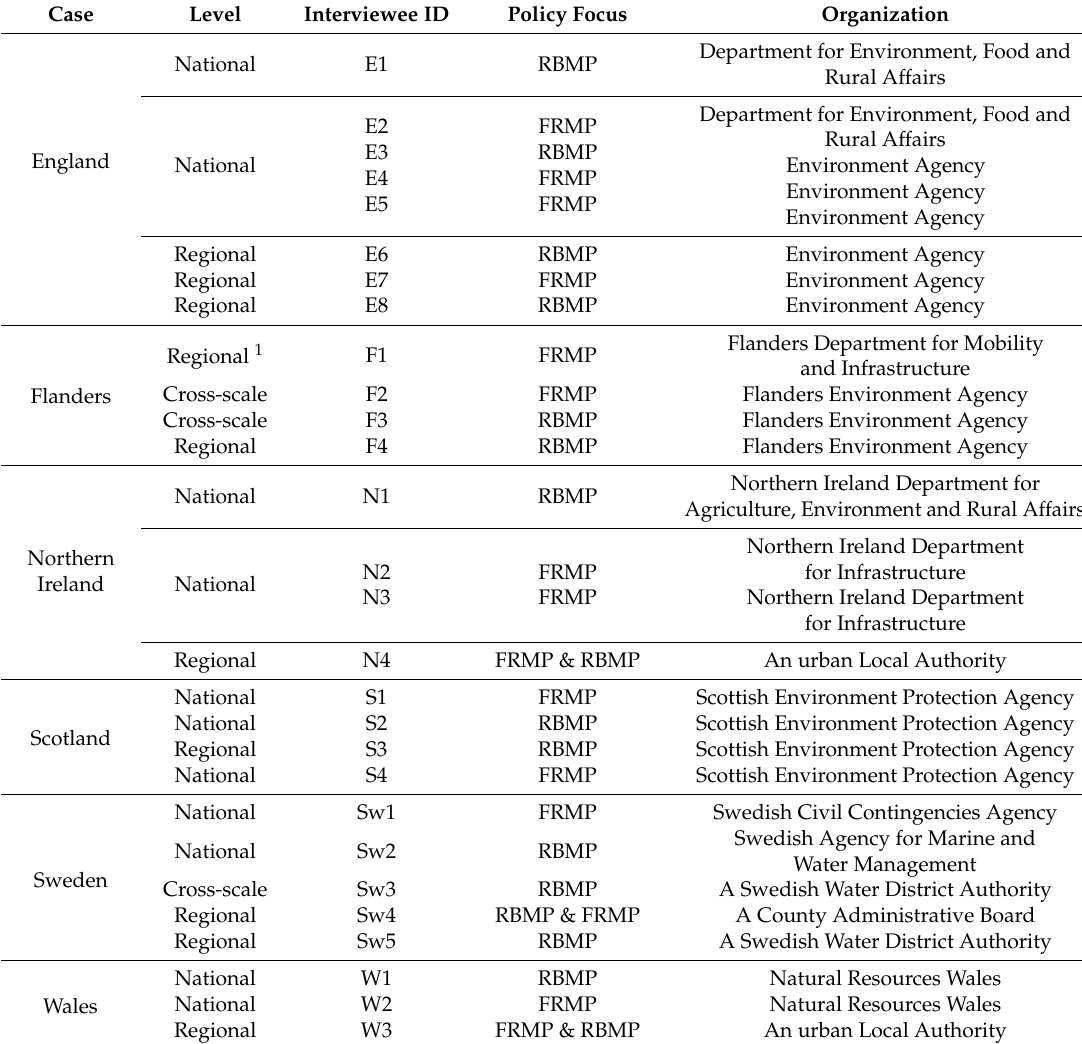
Table A3. Summary of the 28 interviewees who discussed integration.